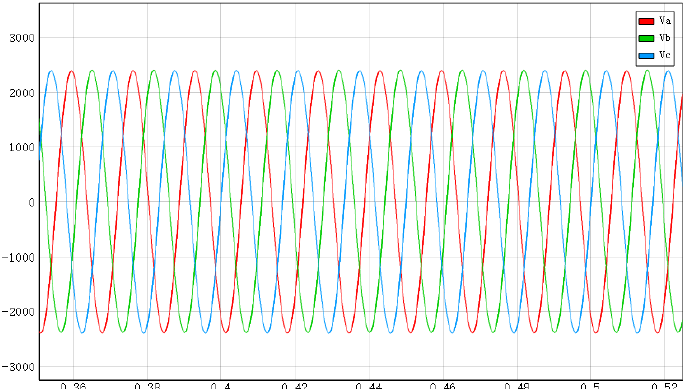
Figure 5. Data waveform obtained by analog port communication.